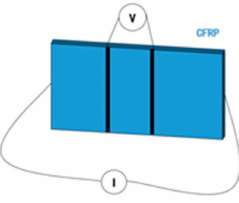
Figure 4. Electrical resistance change method with four